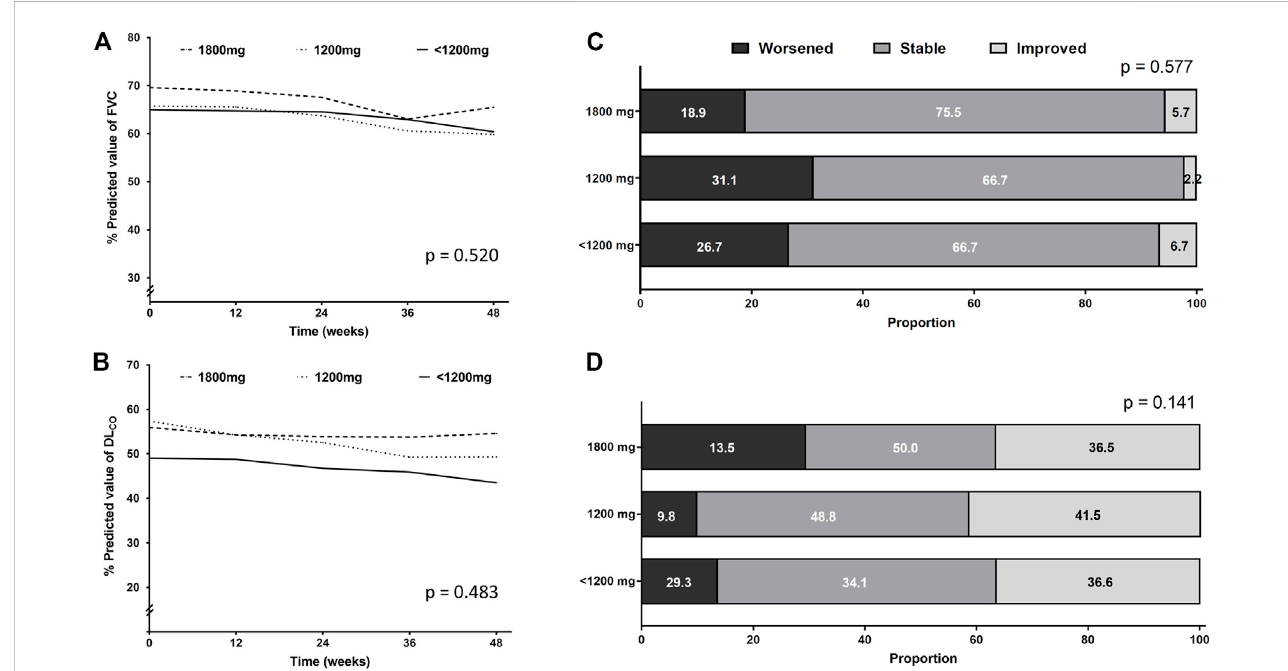
FIGURE 3 Pulmonary function changes according to the pirfenidone dose administered for the longest time. Longitudinal changes in (A) FVC and (B) DL CO . Categoricalevaluationofchangesin (C) FVCand (D) DL CO .Abbreviation:FVC,forcedvitalcapacity; DL CO ,diffusing capacityofthelung